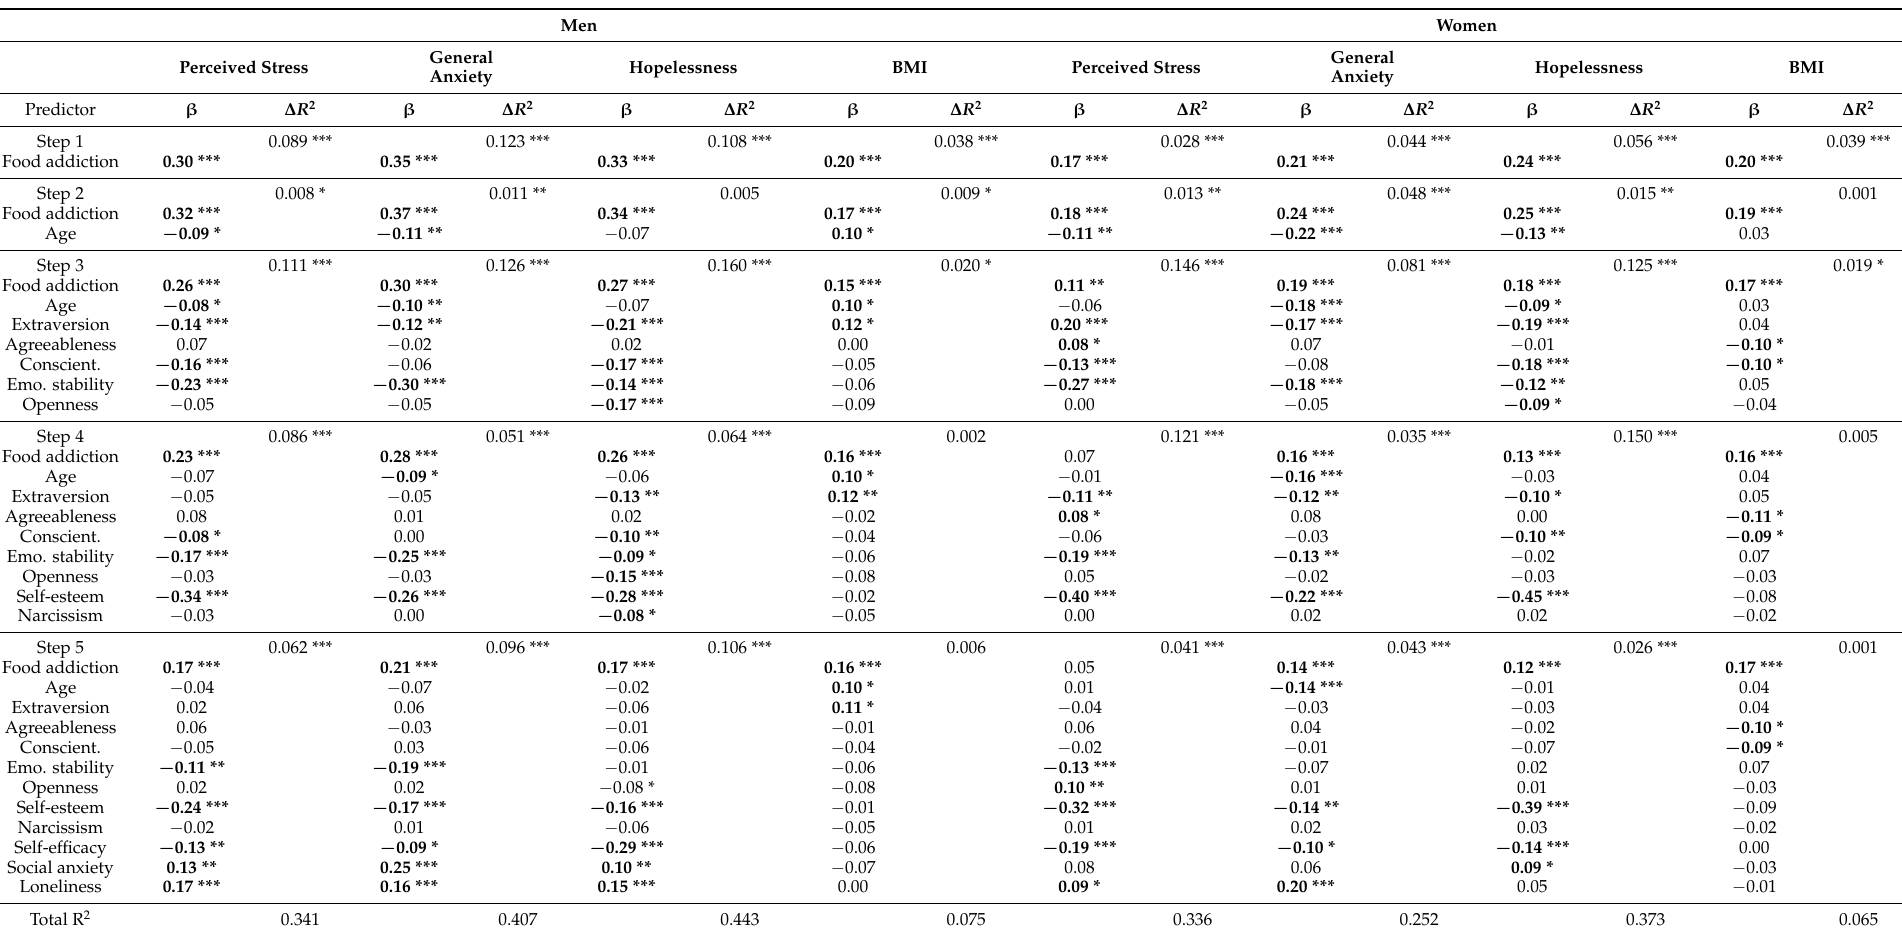
Table 7. Results of hierarchical multiple regression analyses: Food addiction, age, personality, self-esteem, narcissism, self-efficacy, social anxiety, and loneliness as predictors of perceived stress, general anxiety, hopelessness, and BMI for men ( n = 546) and women ( n =